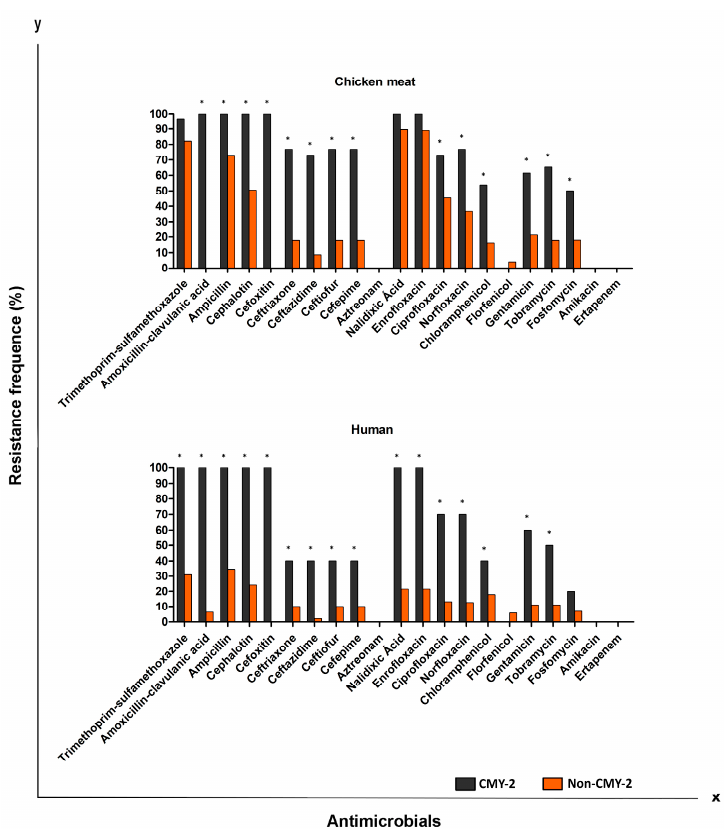
Figure 3. Antimicrobial resistance exhibited by AmpC-producing and non-AmpC-producing P. mirabilis strains isolated from chicken, pork, beef, and UTI-CA. * p < 0.05 by Fisher test.